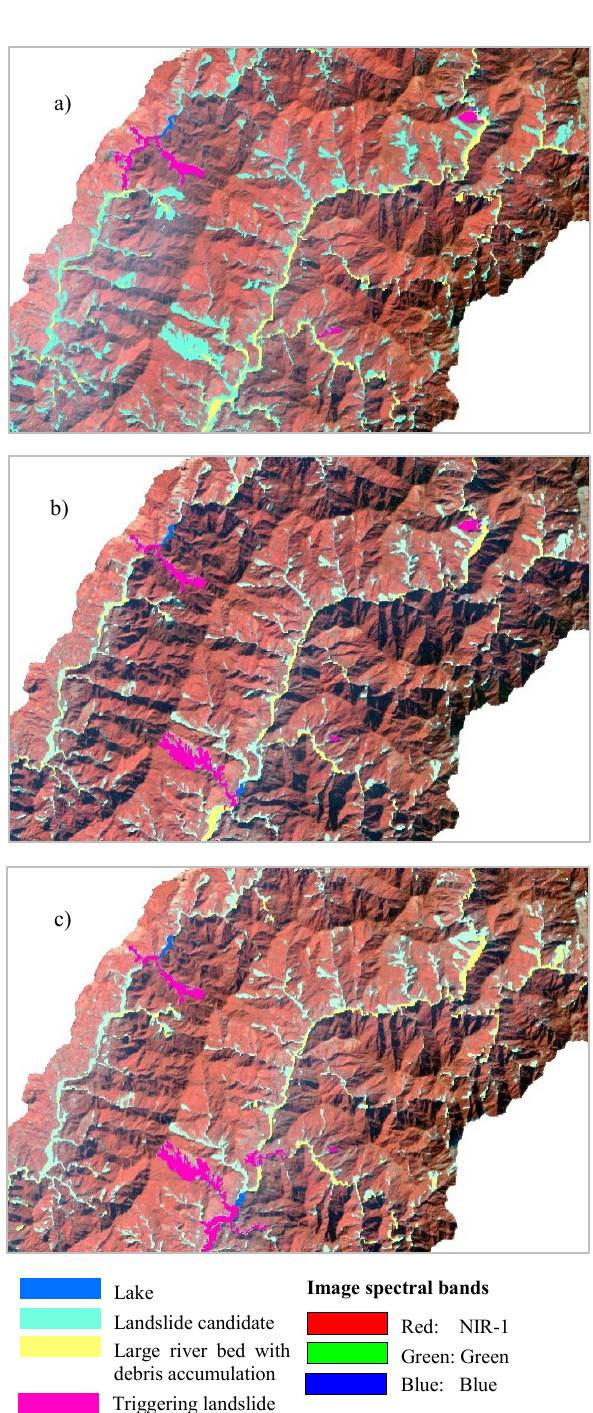
Figure 3. Illustration of the feature extraction results for the Landsat images from a) 2009/10/30, b) 2010/12/20, and c)